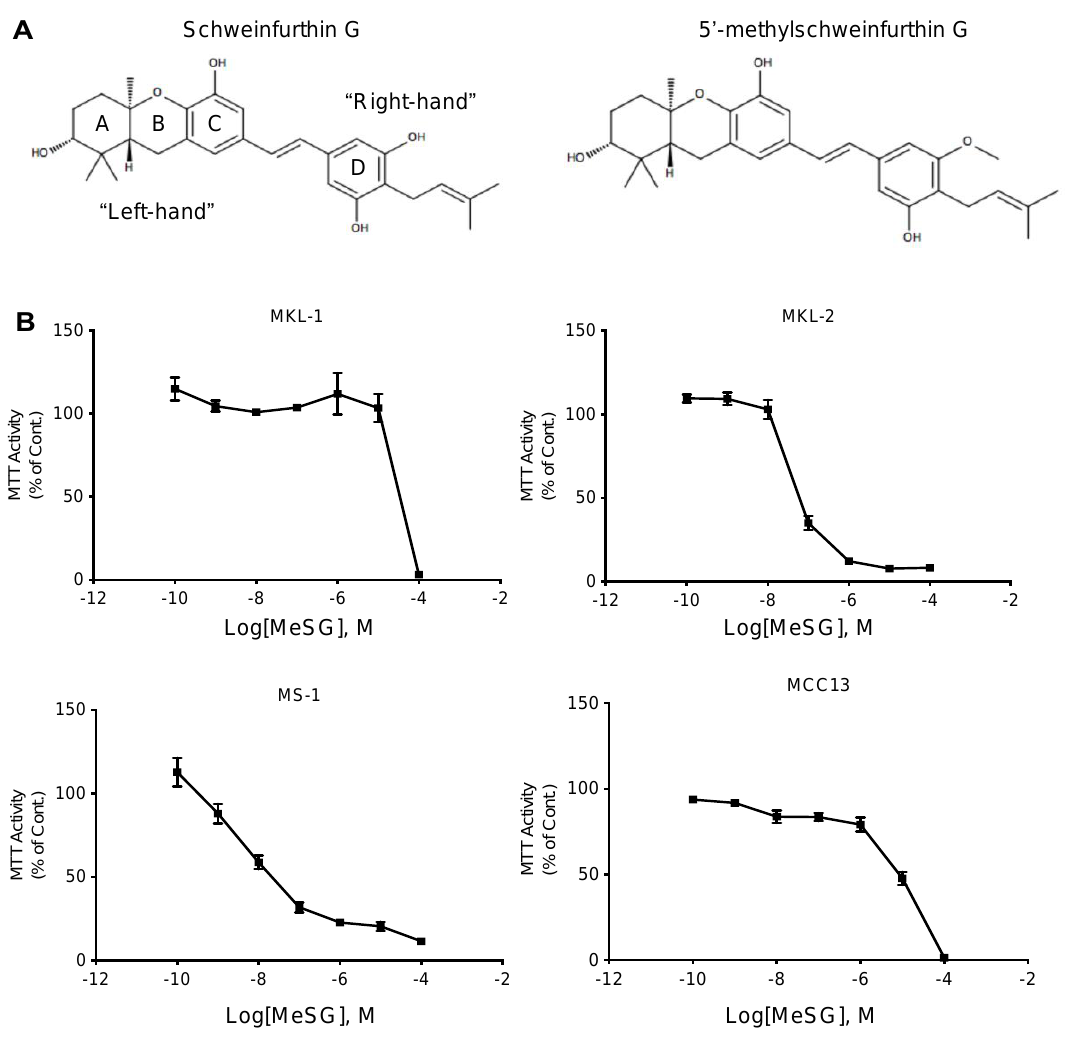
Figure 1. MeSG impairs MTT activity of human Merkel cell carcinoma cell lines. ( A ) Structures of the natural schweinfurthin G and the synthetic schweinfurthin analog MeSG, TTI-3114. ( B ) The human Merkel cell carcinoma cell lines MKL-1, MKL-2, MS-1, and MCC13 were incubated with increasing doses of MeSG (100 pM-100 µ M) for 48 h. The impact of MeSG treatment on MTT activity was assessed by MTT assay. Data are displayed as a percentage of control and are representative of three independent experiments ( n = 3, mean ±